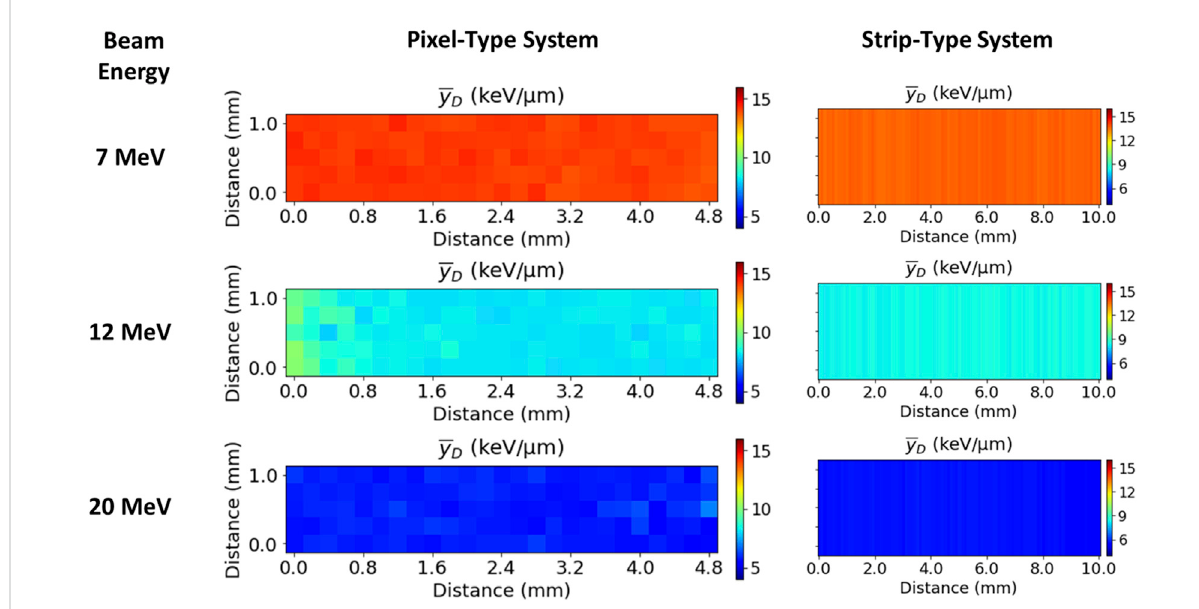
FIGURE 11 Maps of the dose-mean lineal energy (cid:1) y D values obtained with the pixel (left, 2D) and the strip (right, 1D) systems.